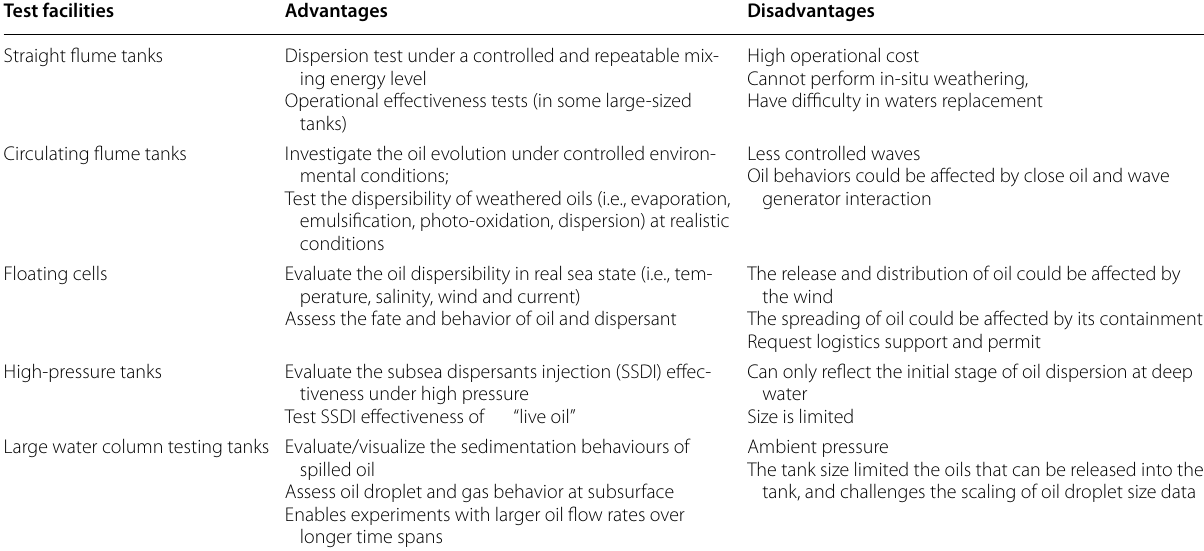
Table 1 Comparison of the mesoscale testing facilities Test